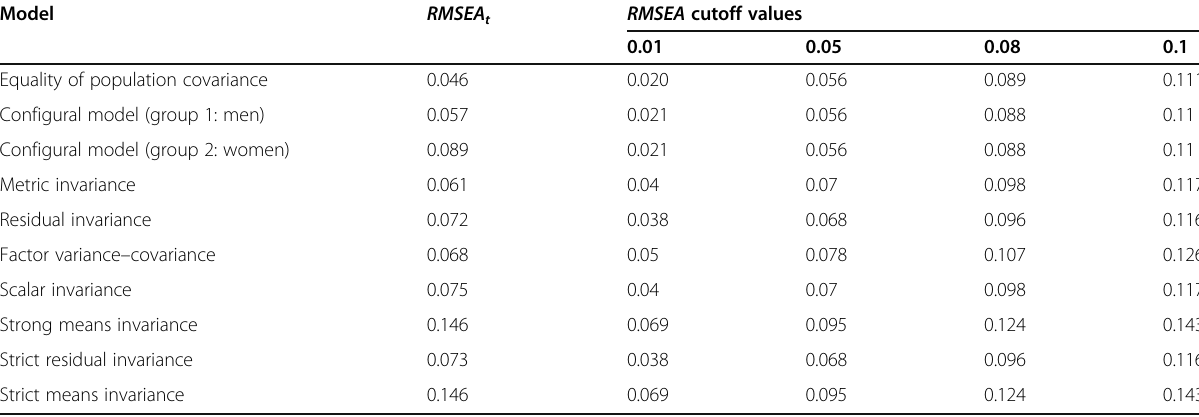
Table 5 Measurement invariance of the WHOQOL-BREF